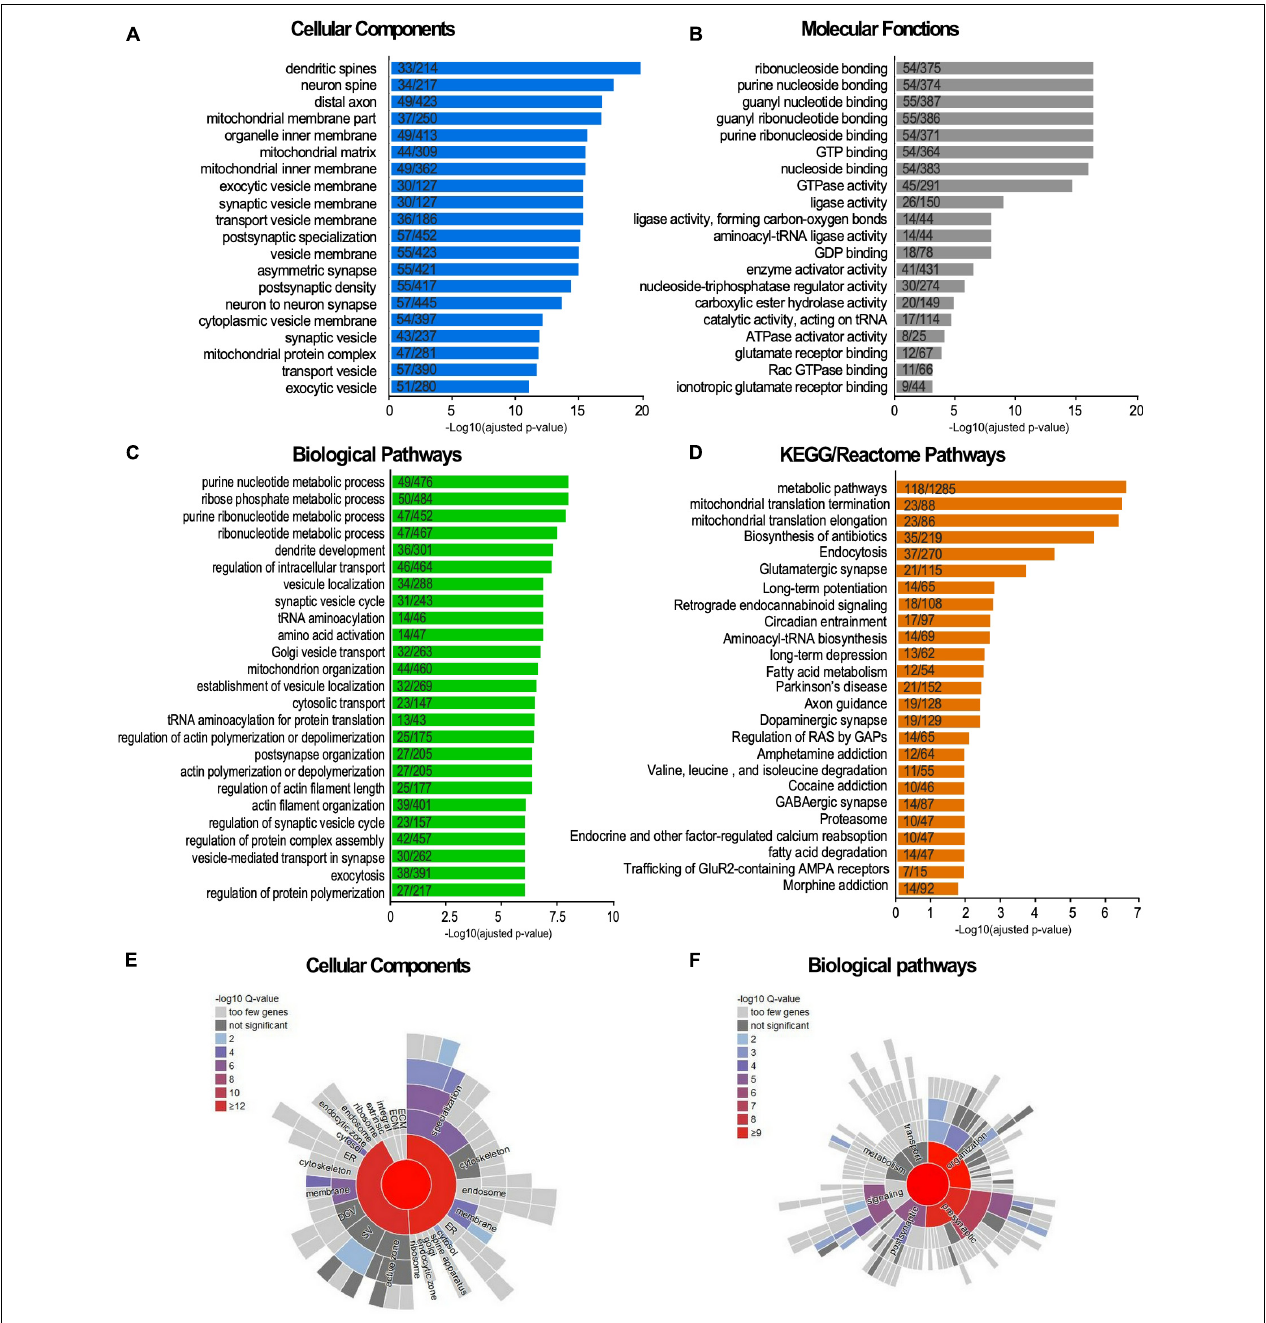
FIGURE 4 | Terms enrichment analysis of the synaptic SUMO2/3-ylome according to the Gene Ontology, KEGG, Reactome and SynGO knowledge bases. (A–D) The list of the SUMO2/3-modified synaptic proteins was subjected to enrichment analysis for GO Cellular Components (A) , GO Molecular functions (B) , GO Biological Pathways terms (C) , for KEGG and Reactome pathways (D) against the rat proteome. Categories were classified according to the -Log10 of the adjusted p -value using the Benjamini- Hochberg method. The number of counts compared to the total number of hits in the category is indicated. The list of the SUMO2/3-modified synaptic proteins was subjected to enrichment analysis for Cellular Components (E) or Biological Pathways (F) using the SynGO synaptic component curator tool. Details are available in Supplementary Table 6 .